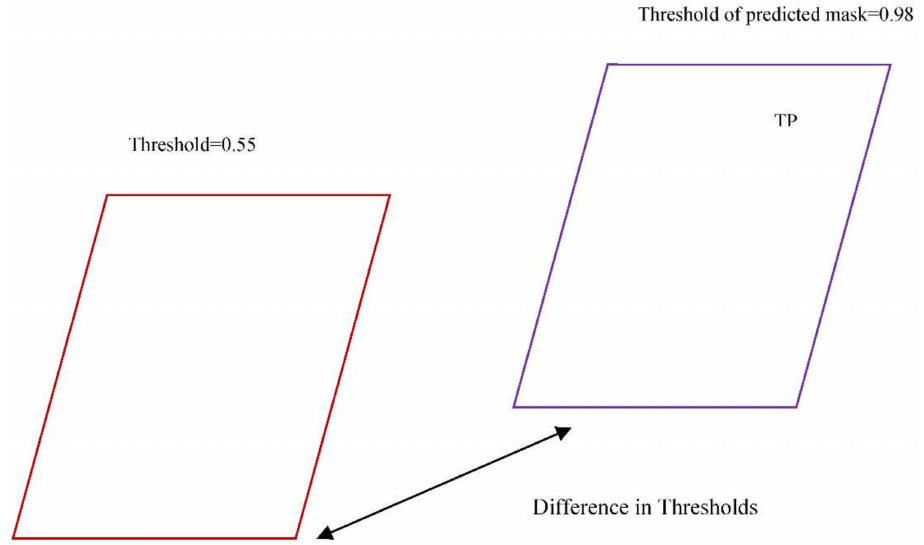
Figure 13. Difference in Thresholds.